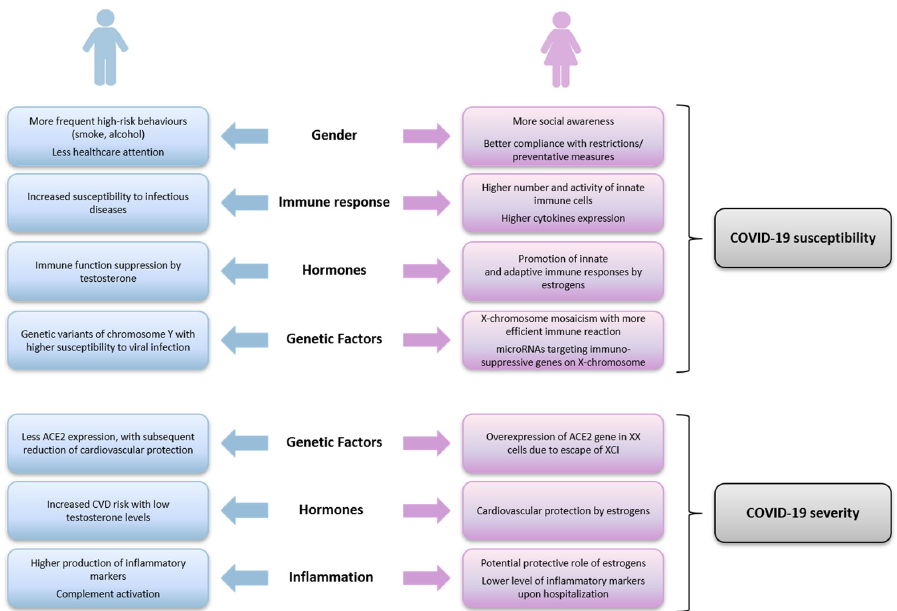
Figure 3. Schematic diagram of sex and gender factors potentially involved in the differential COVID-19 susceptibility and severity between males and females.